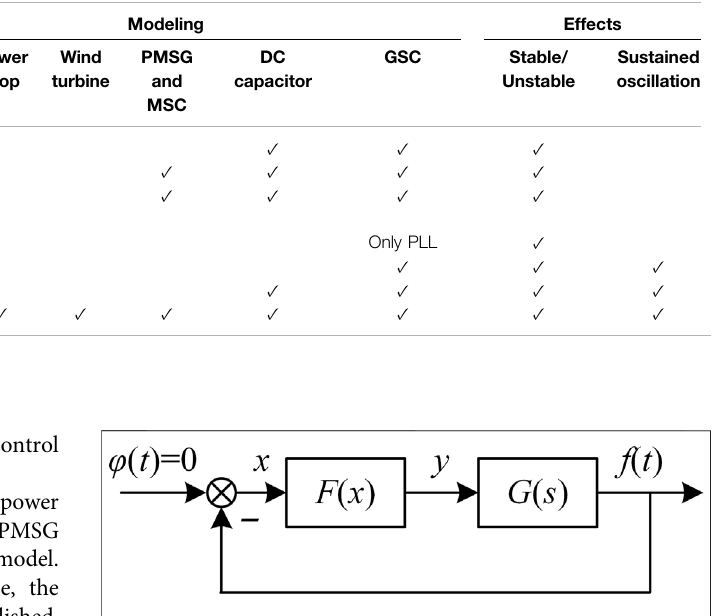
TABLE 1 | Comparison with existing stability analysis methods.